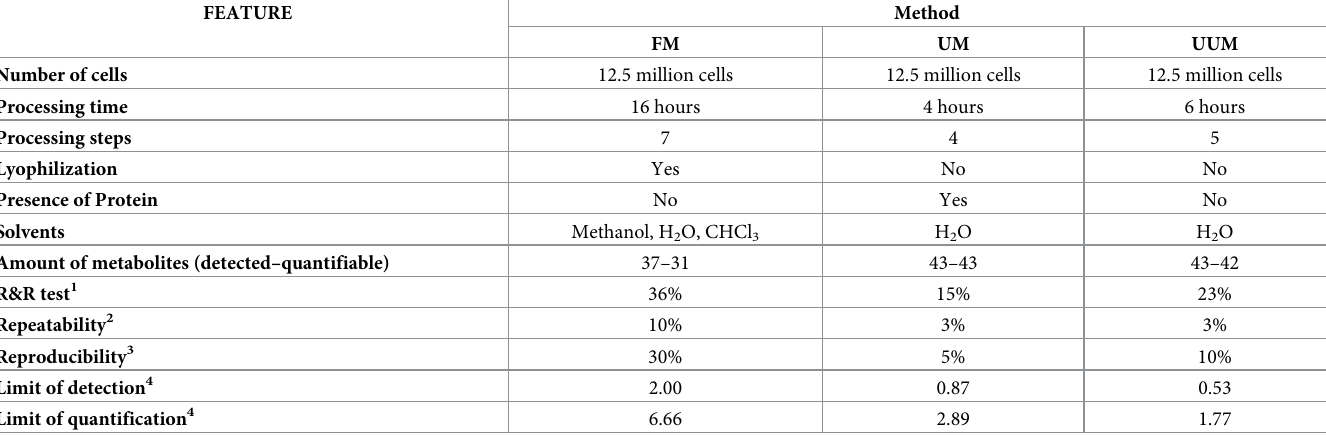
Table 3. General comparison of the three methods tested for the metabolomics profiling of PBMCs by NMR.